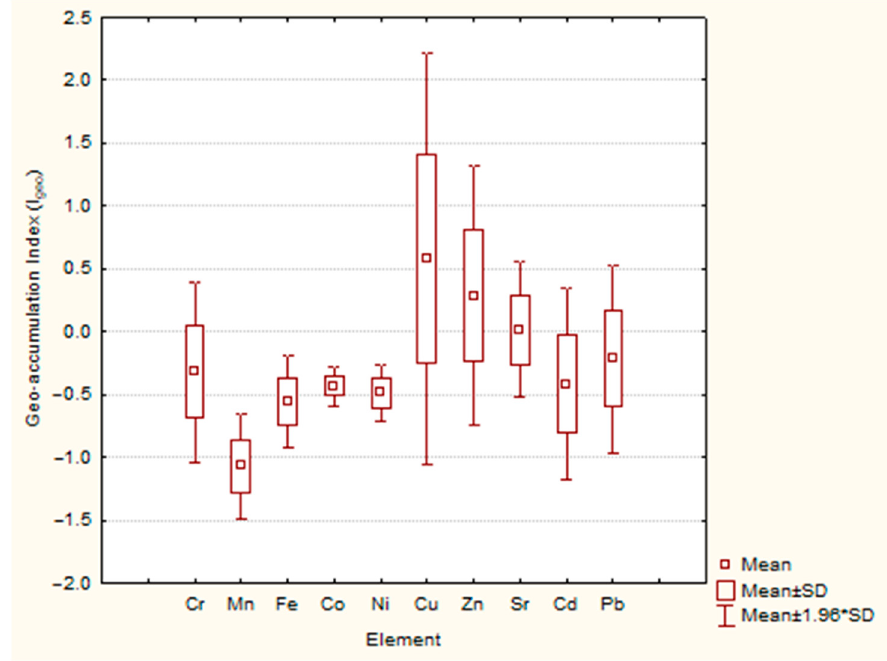
Figure 12. Box plot of Geoaccumulation Index of heavy metals in the road